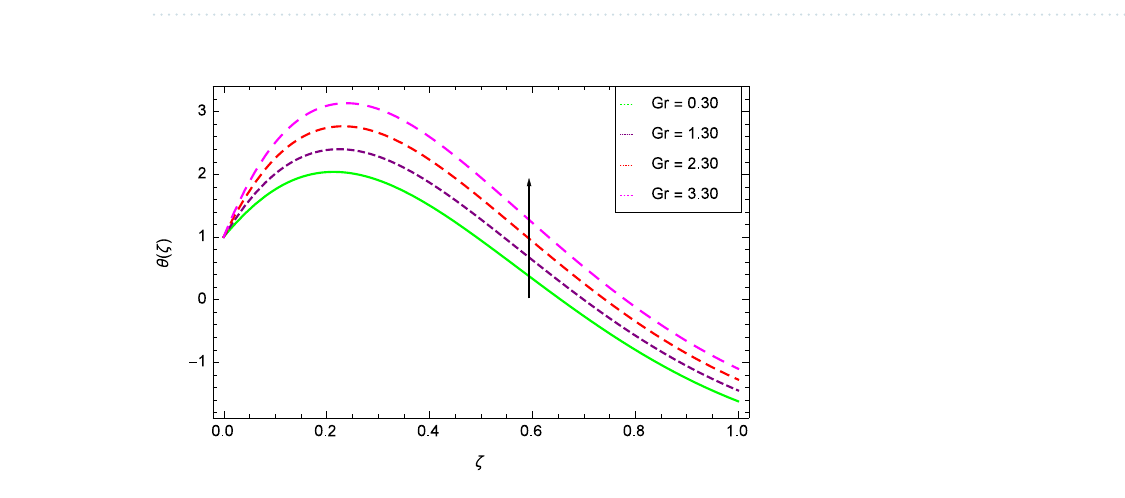
Figure 22. Parameter effect on heat transfer θ ( ζ ) profile.